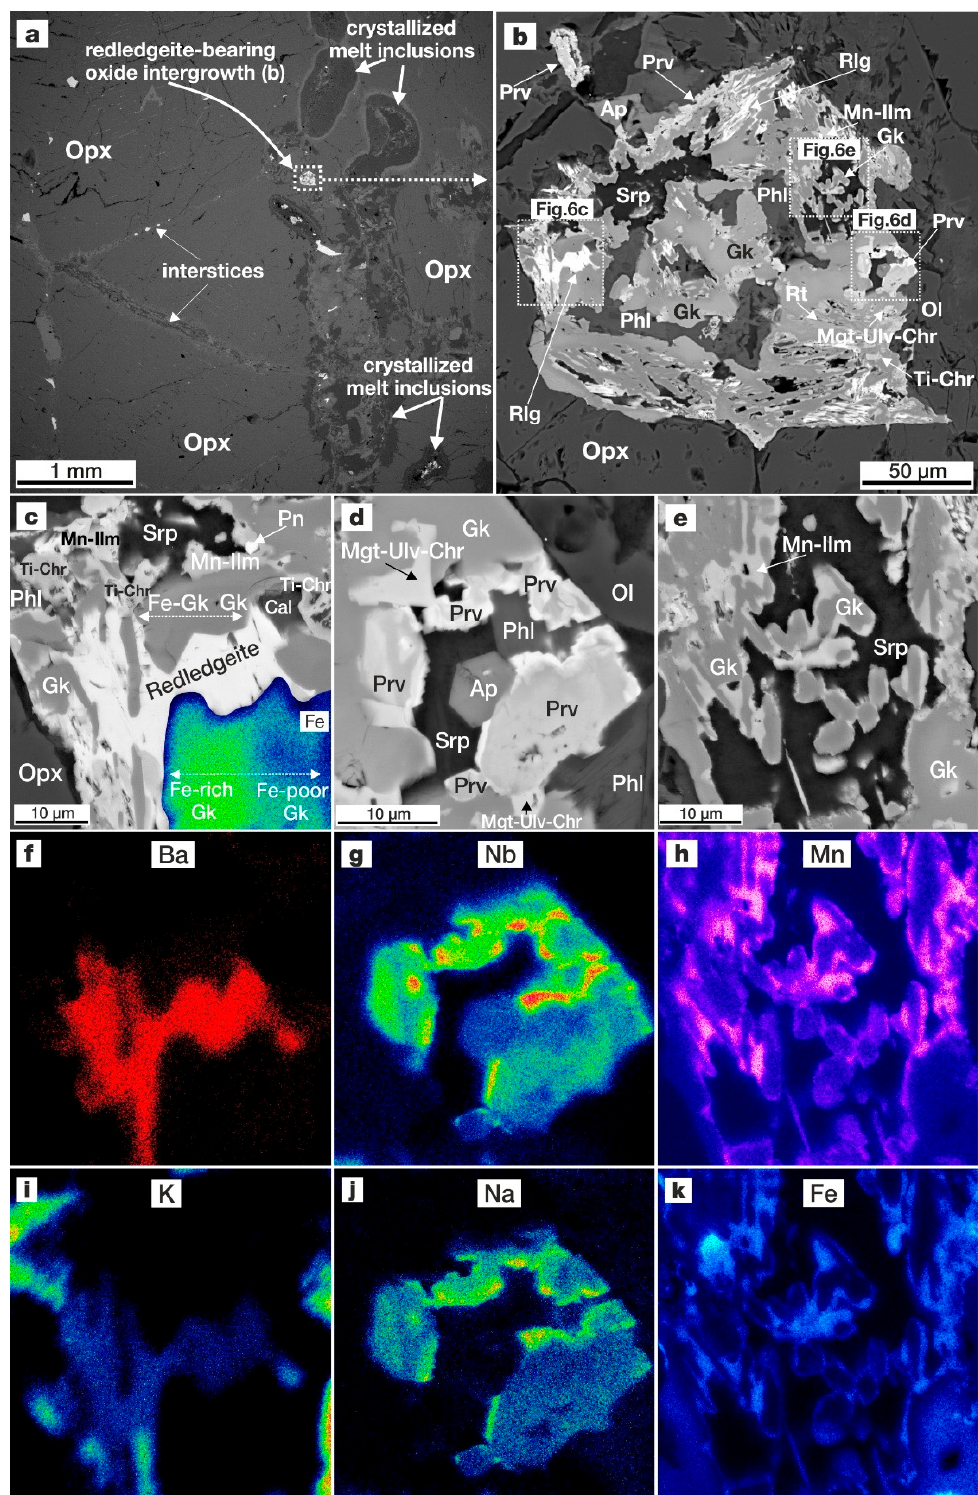
Figure 6. ( a ) BSE image showing an overview of the orthopyroxenite textures in a marginal area with the crystallized melt inclusions; ( b–e ) BSE images showing a characteristic inhomogeneous intergrowth, comprising kimberlitic (geikielite, perovskite, rutile, chromite, magnetite-ulvöspinel-chromite, apatite, phlogopite, olivine, Mn-rich ilmenite, redledgeite) and late-stage hydrothermal (serpentine) minerals; ( f – k ) X-ray elemental maps of the areas shown in ( c–e ), respectively. Mineral abbreviations are those described in the section “Materials and Methods” and Table